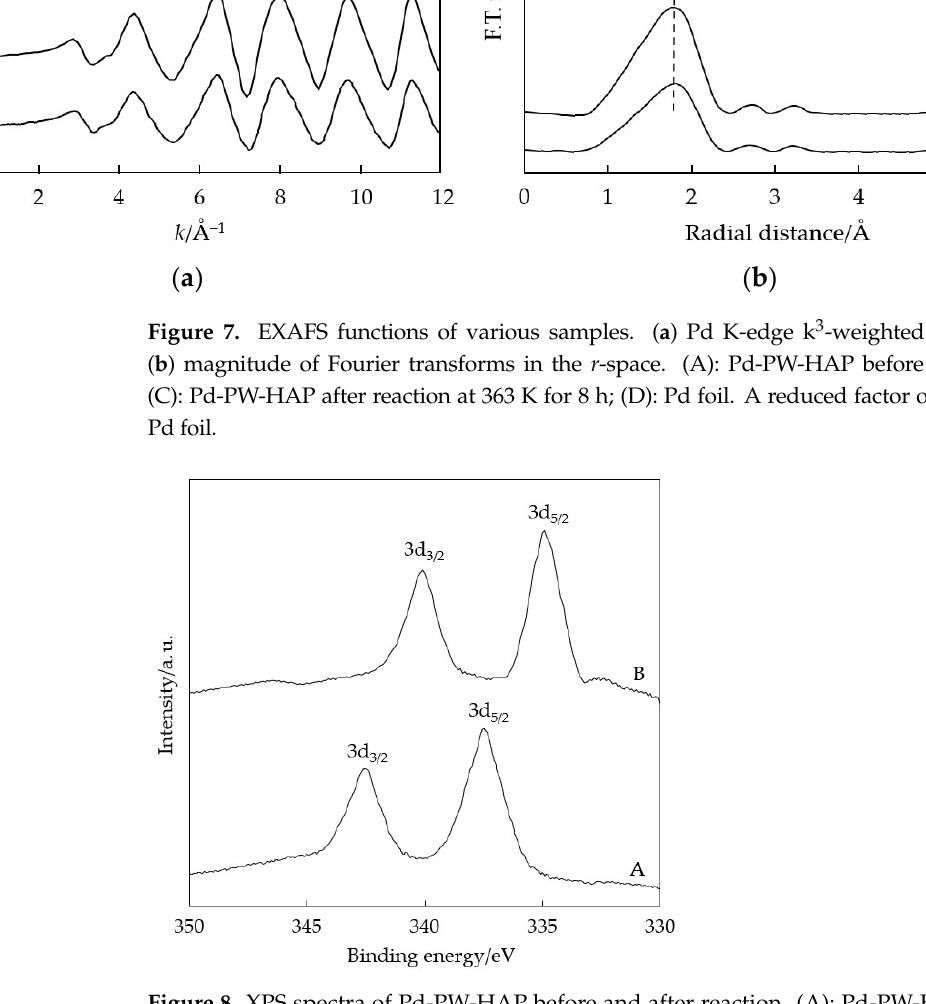
Figure 7. EXAFS functions of various samples. ( a ) Pd K-edge k 3 -weighted EXAFS spectra and ( b ) magnitude of Fourier transforms in the r -space. (A): Pd-PW-HAP before reaction; (B): PdCl 2 ; (C): Pd- PW-HAP after reaction at 363 K for 8 h; (D): Pd foil. A reduced factor of 0.5 was applied for Pd foil.